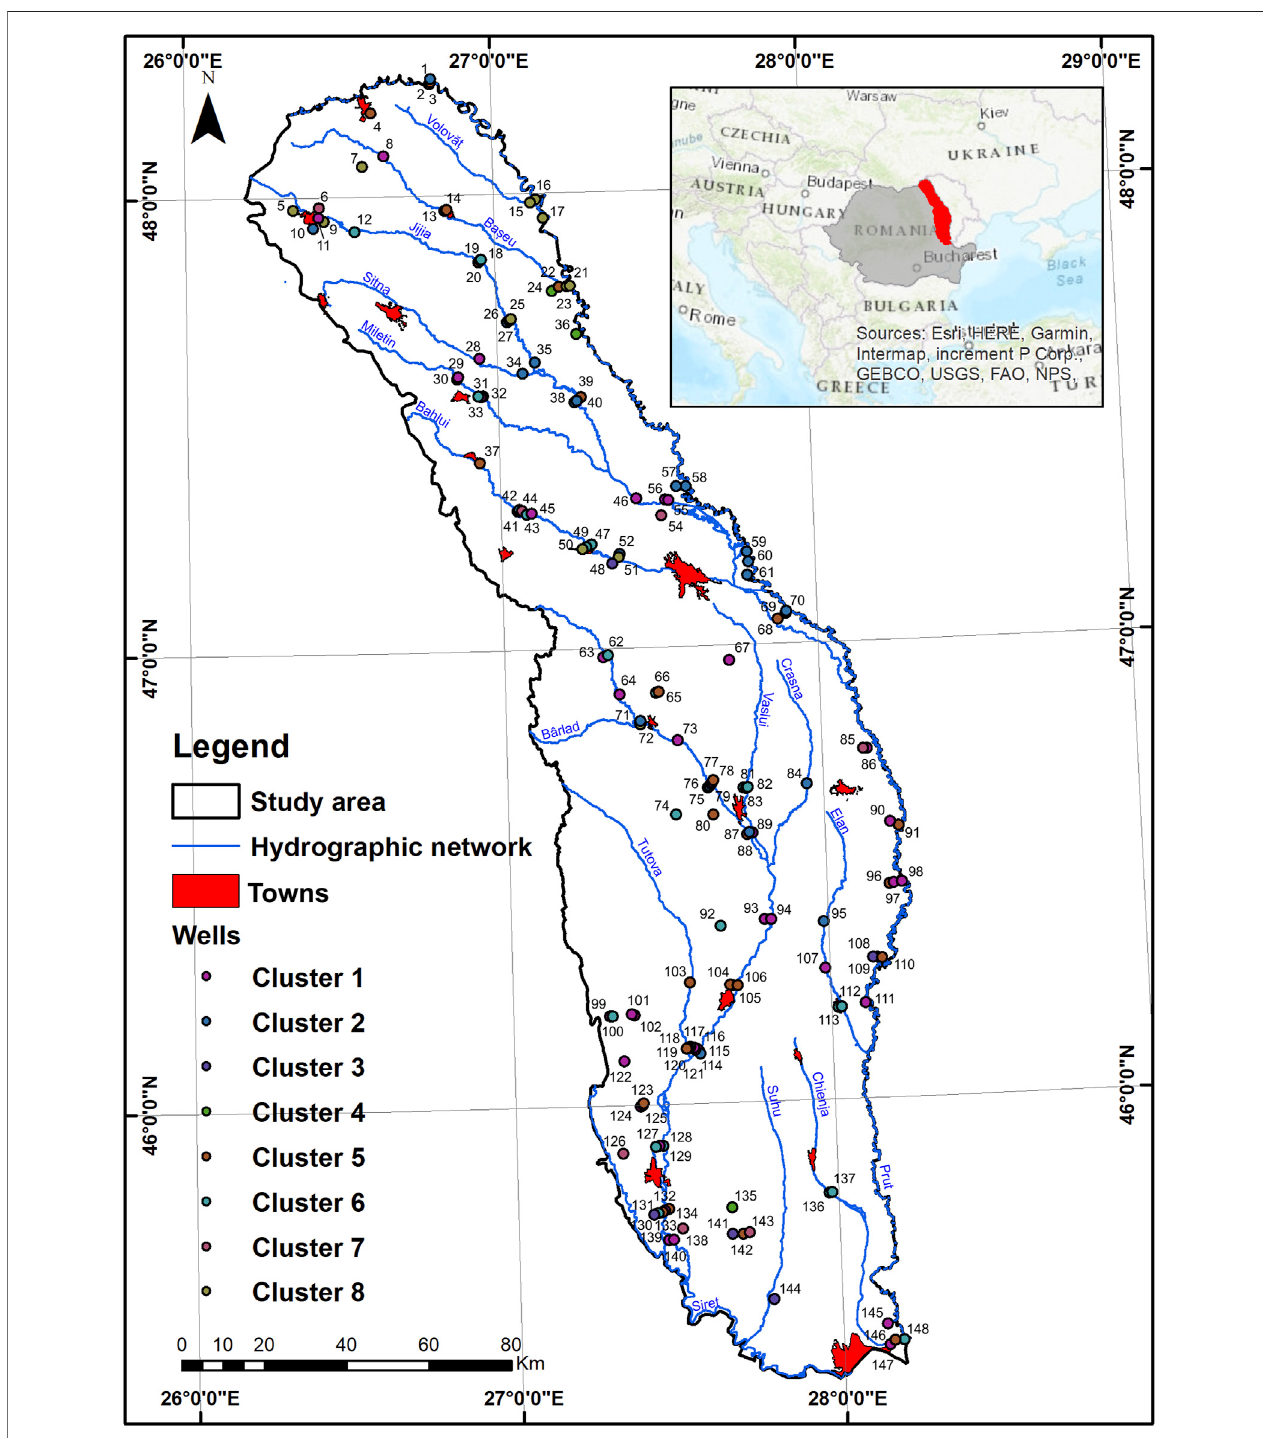
FIGURE 1 | The geographical position of hydrogeological wells analyzed from Eastern